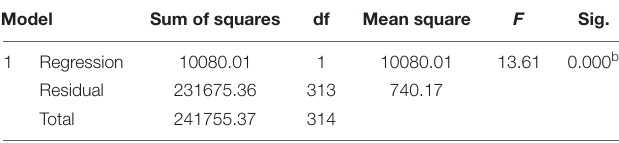
TABLE 7 | ANOVA for Chinese EFL PC and AO.